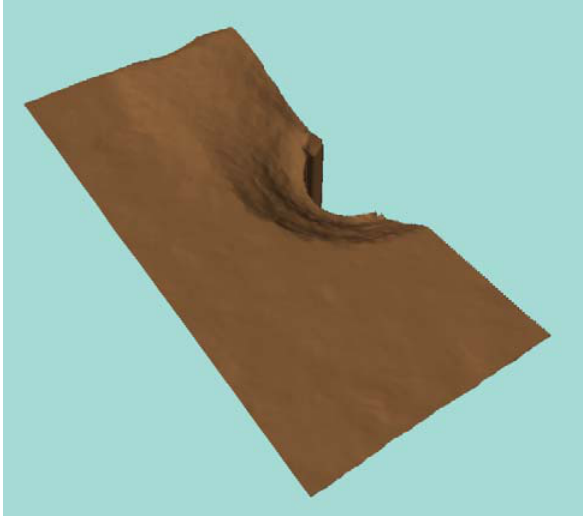
Figure 5. Perspective view of the DEM (state 119 sec.)